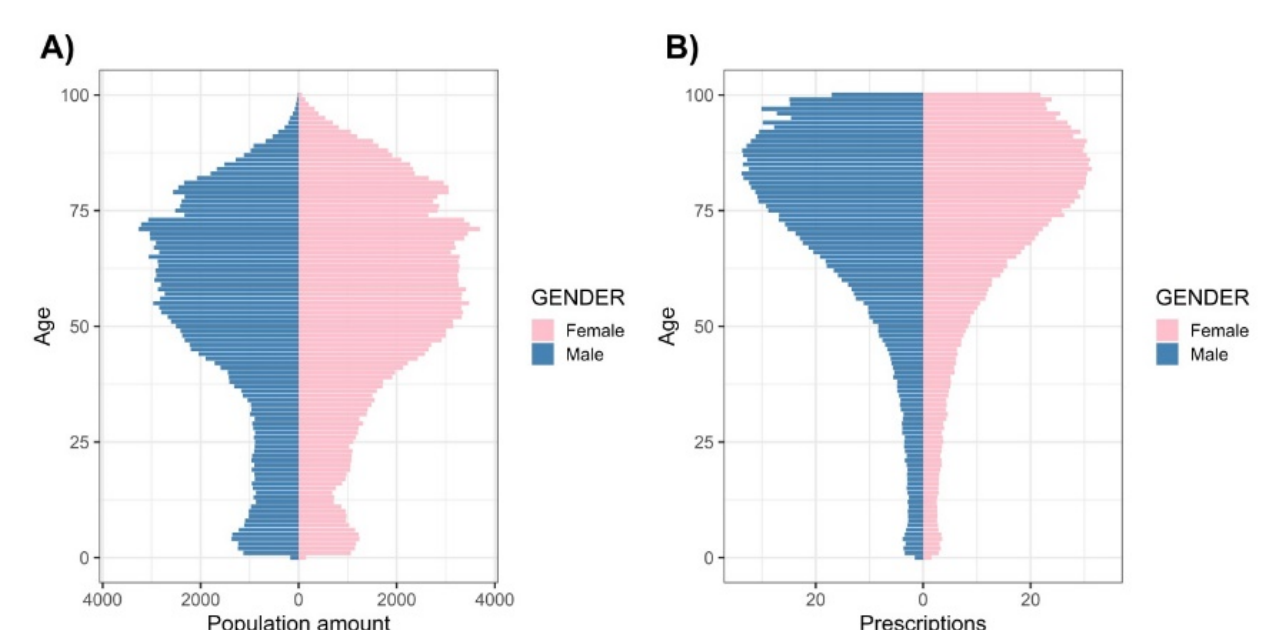
Figure 2. Study population. A total of 5,431,335 entries/drugs prescribed to 361,574 patients were analysed in this study. Panel ( A ) shows age and sex structures of the study population. Panel ( B ) shows relative prescriptions (all prescriptions/patient) classified by age and gender.